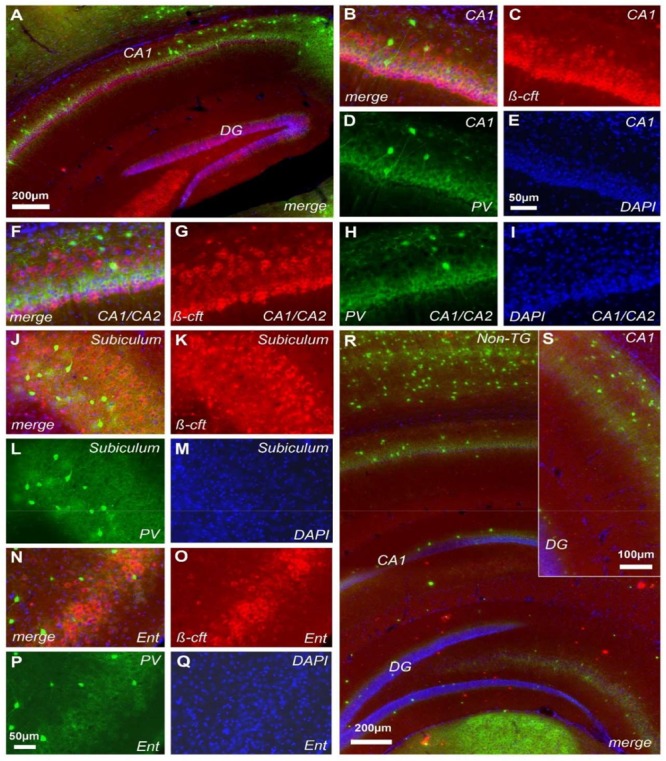
Cerebral b-CTF deposition in J20 mice. Immunohistochemical staining in the hippocampus of J20-TG mice with CT20 (red), PV (green), and DAPI (blue) reveals the presence of b-CTF in CA1 and DG (A). Further characterization showed that b-CTF is predominantly present in the deeper pyramidal layer along CA1 (B–I). b-CTF was also found in the subiculum (J–M) and entorhinal cortex (N–Q). Control mice did not display b-CTF presence in the hippocampal formation (R,S). See magnification in S7, n = 8, non-TG and 7, TG.